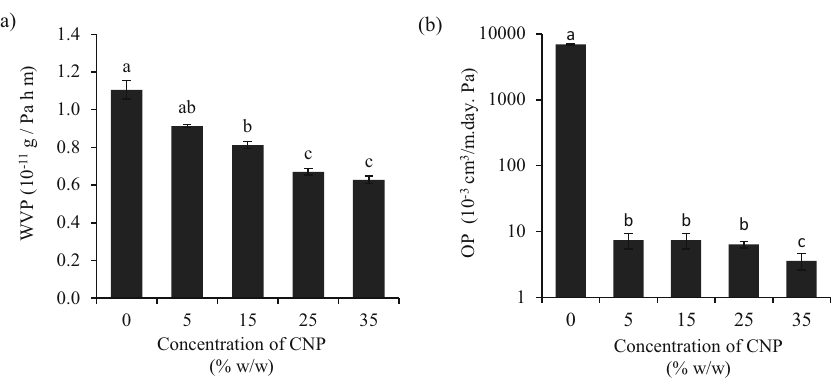
Figure 6: E ff ect of CNP concentration on the barrier properties of starch fi lms: ( a ) water vapor permeability ( WVP ) and ( b ) oxygen perme - ability ( OP )